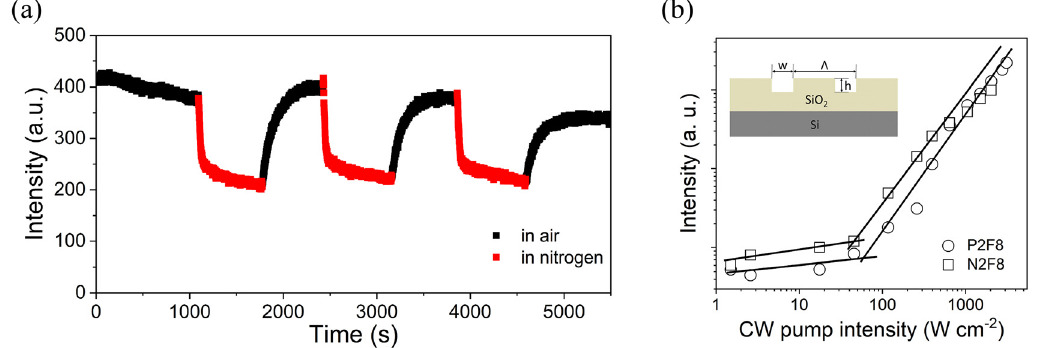
Figure 8: (a) Lasing intensity variation for PEA-based perovskites thin films under continue illumination in air and nitrogen. (b) Lasing threshold for PEA- and NMA-based perovskites thin films (corresponding to P2F8 and N2F8) under CW laser excitation (Insert: schematic diagram of DFB